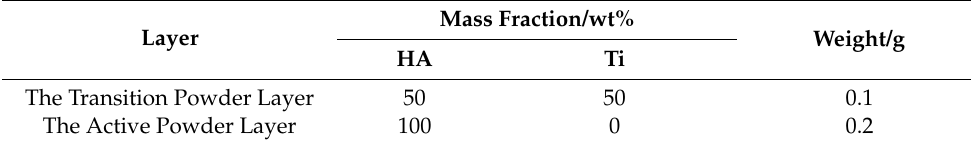
Table 1. Table of preplaced multilayer powder. Layer